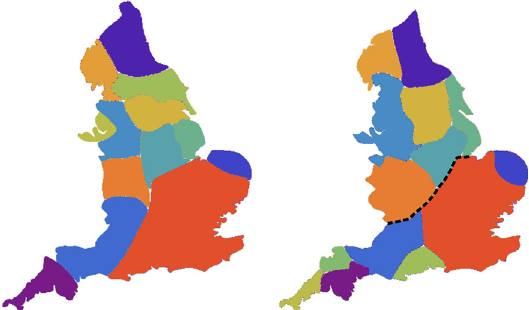
FIG. 7. Left map: Future England dialect boundaries predicted by Trudgill [4]. Right map: Future dialect boundaries predicted using k -medoids cluster analysis of 20 synthetic binary linguistic variables when σ ¼ 10 km and β ¼ 1 . 1 at t ¼ 150 . Levenshtein distance (or “ edit distance ” ) [9] used as distance metric. Colors, determined by Hungarian method, show mapping between dialect areas. Black dotted line shows north-south isogloss.